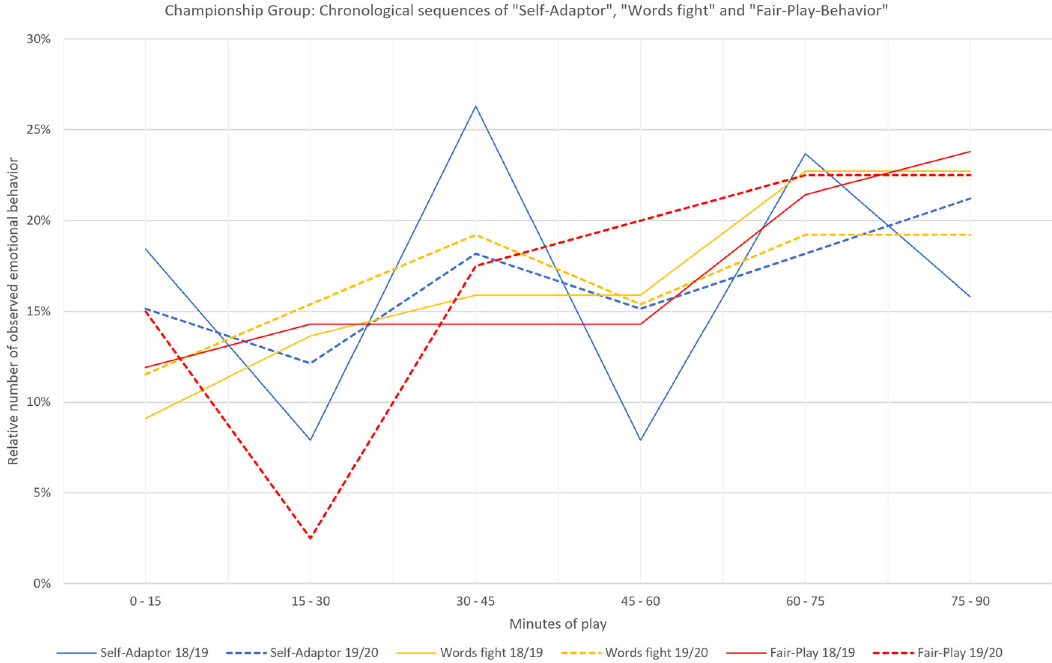
Fig. 6 Chronological sequences of “ Self-Adaptor ” , “ Words fi ght ” , and “ Fair-Play-Behavior ” . Chronological development of relative numbers of players displaying “ Self-Adaptor ” , “ Words fi ght ” , and “ Fair-Play-Behavior ” in matches of FC Red Bull Salzburg (RBS) during the championship group phase in both seasons of 2018/19 (continuous lines) and 2019/20 (dotted lines). Graphical distribution illustrates a similar pattern for “ Self-Adaptor ” across seasons over time (continuous blue line: season 18/19 / dotted blue line: season 19/20), indicating that “ ghost games ” in fl uence the number of observable “ Self- Adaptor ” , but not the frequency of occurrence in the different phases of a professional football match. Graphical distribution illustrates a similar pattern for “ Words fi ght ” across seasons over time (continuous yellow line: season 18/19/ dotted yellow line: season 19/20), indicating that “ ghost games ” in fl uence the number of observable “ Words fi ght ” in the fi rst half — leading to more “ Words fi ght ” in “ ghost games ” . In contrast, more “ Words fi ght ” can be documented in season 18/19 in the second half. Data further indicates that there is a constant chronological increase in “ Words fi ght ” in both seasons and that the effect of “ ghost games ” seems marginal and balances out over time. Regarding “ Fair-Play-Behavior ” a noticeable decline in “ ghost games ” of season 19/20 (dotted red line) in the mid of the fi rst half is evident, followed by a subsequent rise, similar to changes in season 18/19 (continuous red